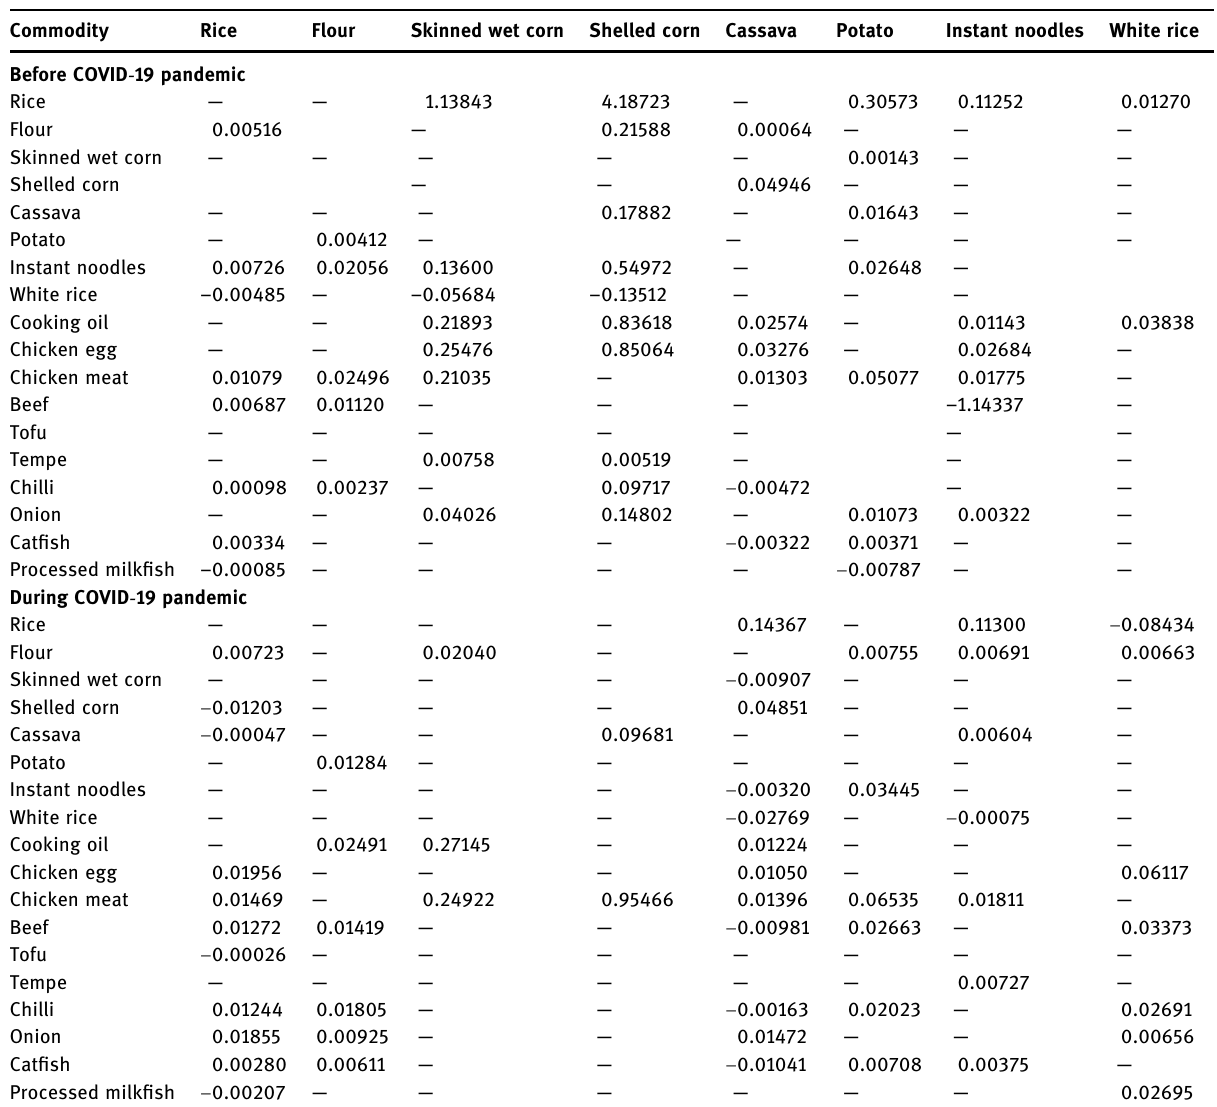
Table 4: Cross - price elasticity of the pandemic Commodity Rice Flour Skinned wet corn Shelled corn Cassava Potato Instant noodles White rice Before COVID - 19 pandemic Rice Flour Skinned wet corn — — — Shelled corn — — Cassava Potato 0.00412 Instant noodles White rice Cooking oil Chicken egg Chicken